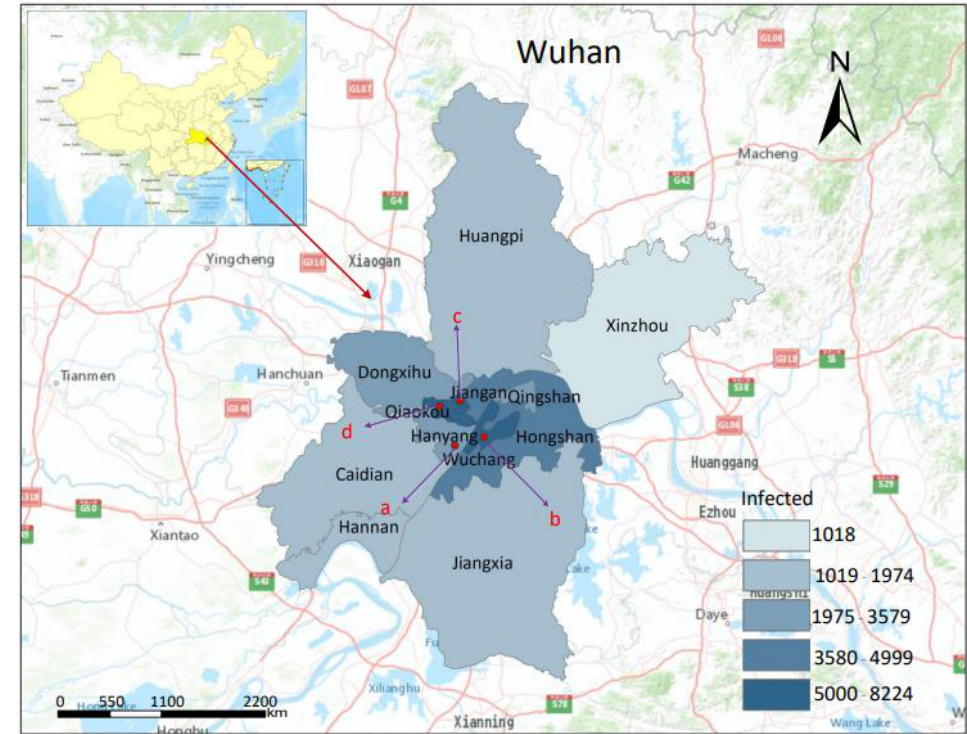
Figure 1. Map showing the location of Wuhan, 13 districts, 4 representative layouts of residential area (a: points layout, b: parallel layout, c: center-around layout, d: mixed layout), and infection numbers during the COVID-19 outbreak.